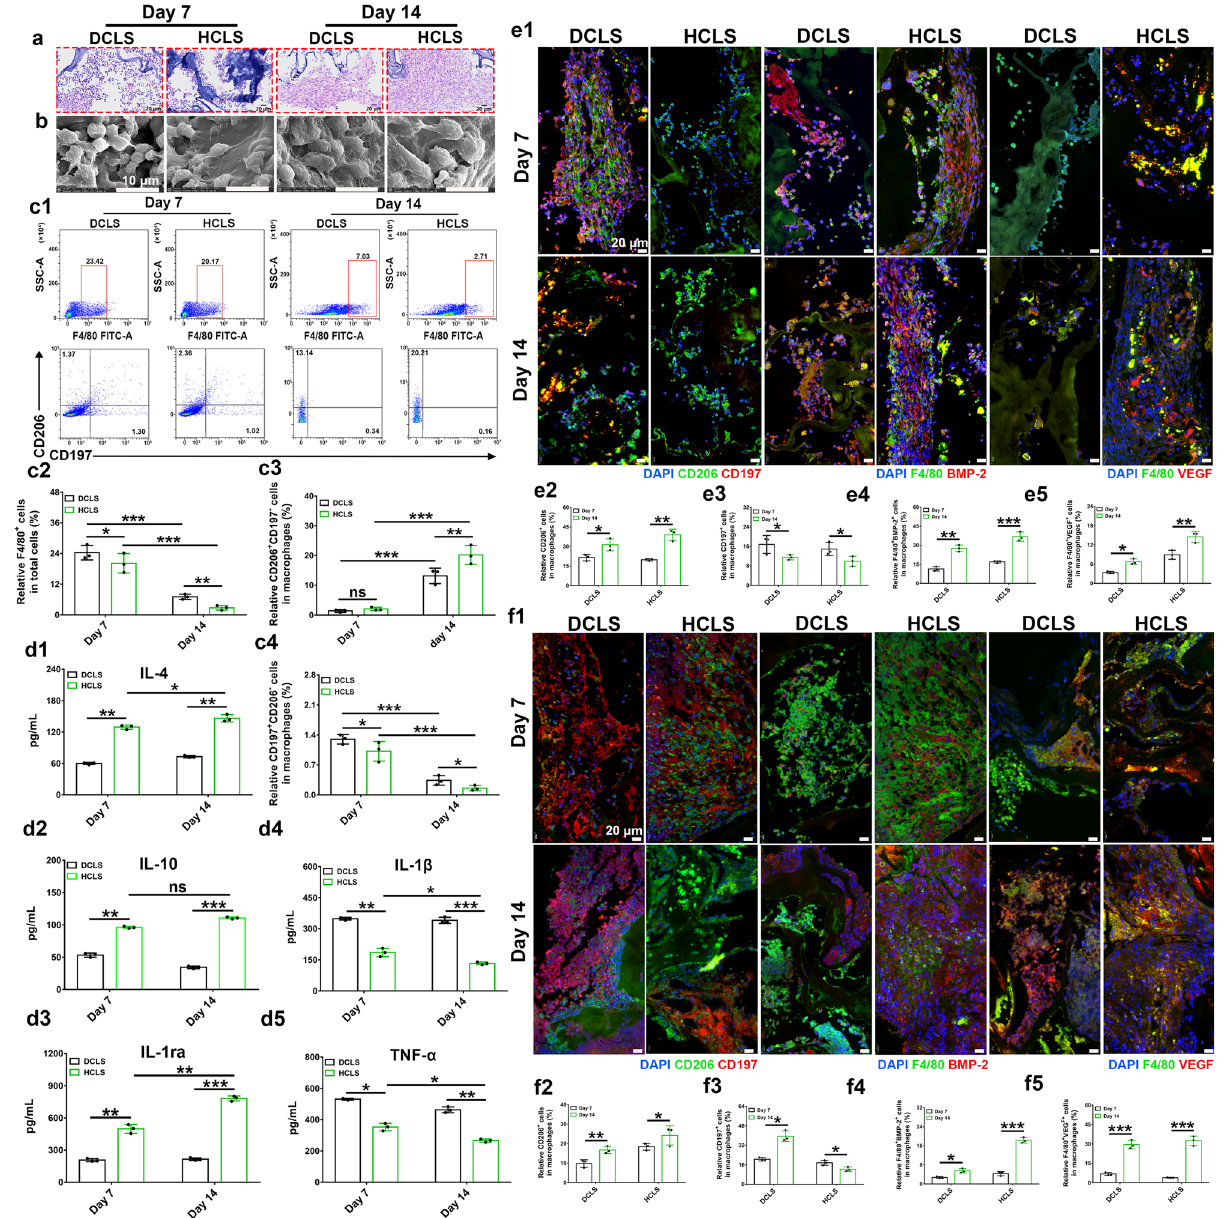
Fig. 3 In vivo immune response of scaffold in mouse intramuscular and rabbit skull defect model. a H&E staining of implants on days 7 and 14